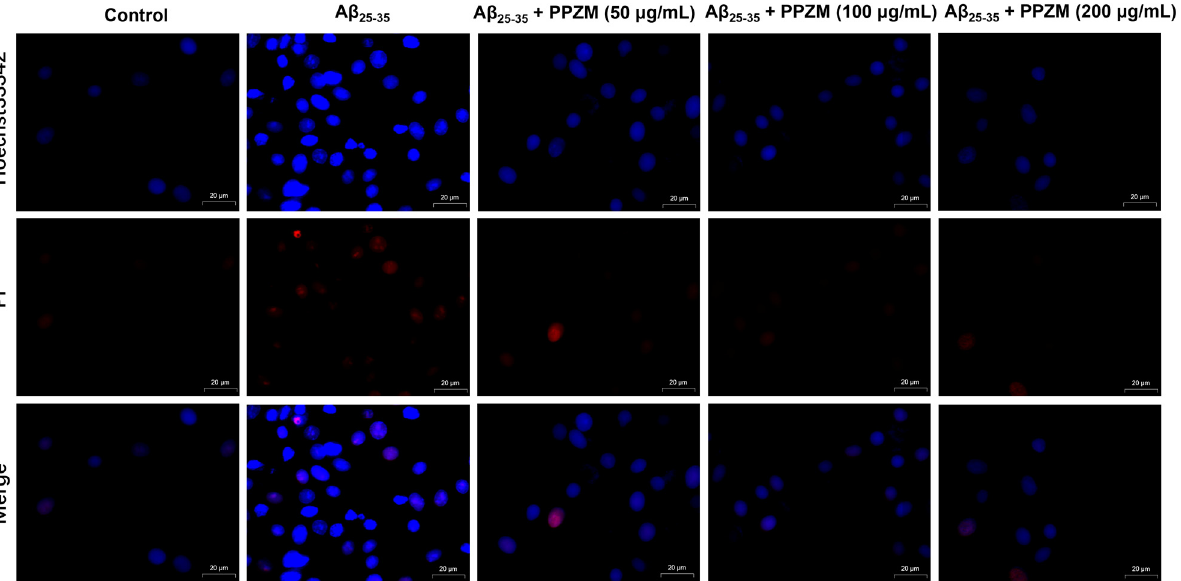
Figure 3. Effects of PPZM on A β 25–35 -induced PC12 cell apoptosis based on flow cytometry analysis. Results are presented as the mean ± SD. ## p < 0.01 vs. the control group; ** p < 0.01 vs. the A β 25–25 treated group.